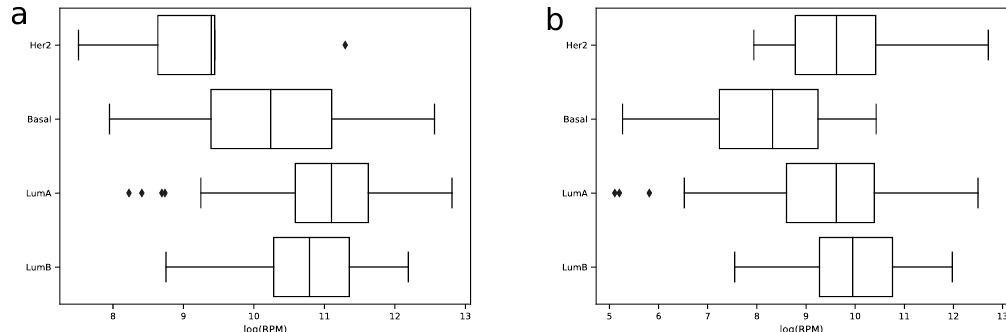
Figure 4. Distribution of hsa-miR-30-5p ( a ) and hsa-miR-375-3p ( b ) log in samples of four breast cancer molecular subtypes in the TCGA miRNA-seq